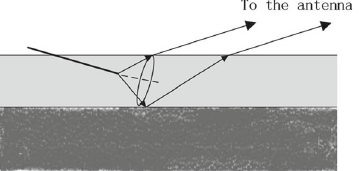
Fig. 2 Askaryan radio emissions initiated by UHE cosmic rays prop- agate between the lunar soil and lunar orbital radio antenna. The lunar soil is modelled with two layers, the regolith and the sub-regolith